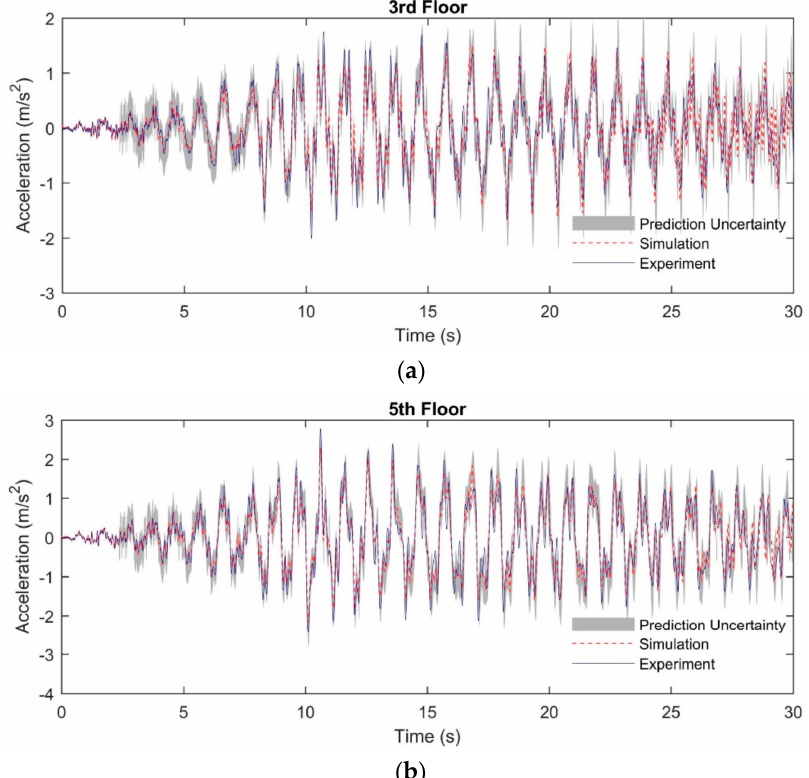
Figure 20. Prediction uncertainty ranges of acceleration histories in the nonlinear structural system: ( a ) At the 3rd floor; ( b ) At the 5th floor.